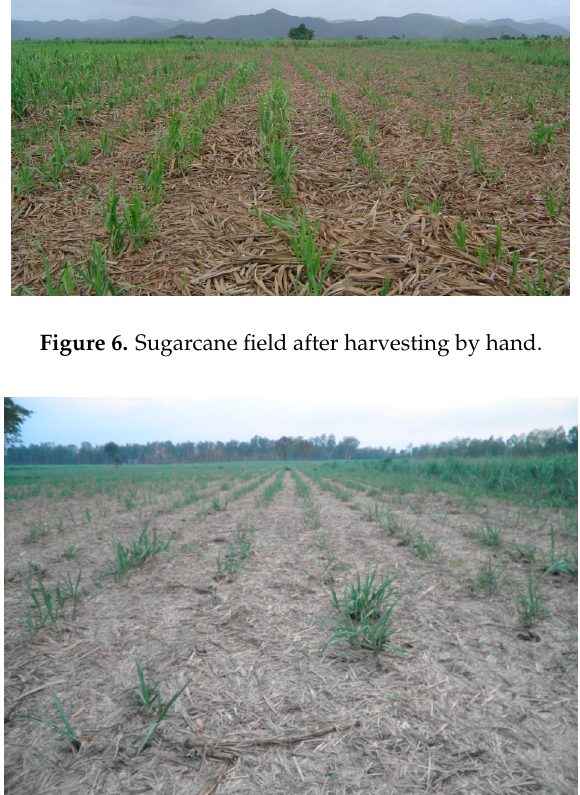
Figure 8. Inter-row cultivator operating in the field. Figure 9. Sugarcane residues after being mixed into the soil by the inter-row cultivator.